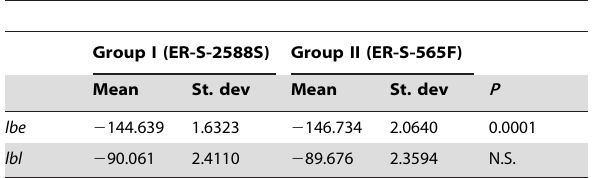
we propose that lbe synonymous polymorphisms may be important contributors to adaptive variation in D. melanogaster . Because there was no difference in secondary structure stability between lbl mRNA transcripts representing two main haplotype groups, mRNA secondary structure for this gene may not be a target for Table 4. Free energy ( D G, kcal/mol) of lbe and lbl mRNA base pairing.